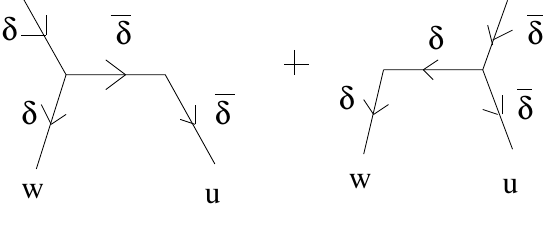
Figure 7 . Skeleton graphs for (cid:8) 2 ;C .